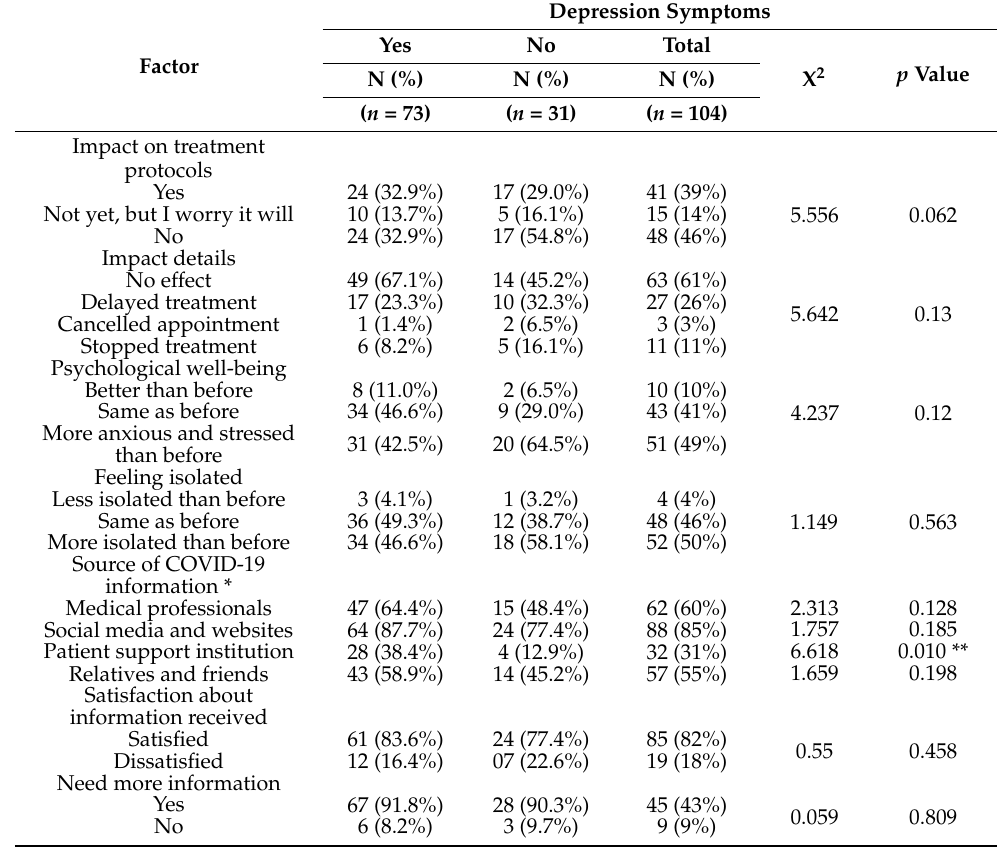
Table 4. Impact of COVID-19 in relation to depression ( n =